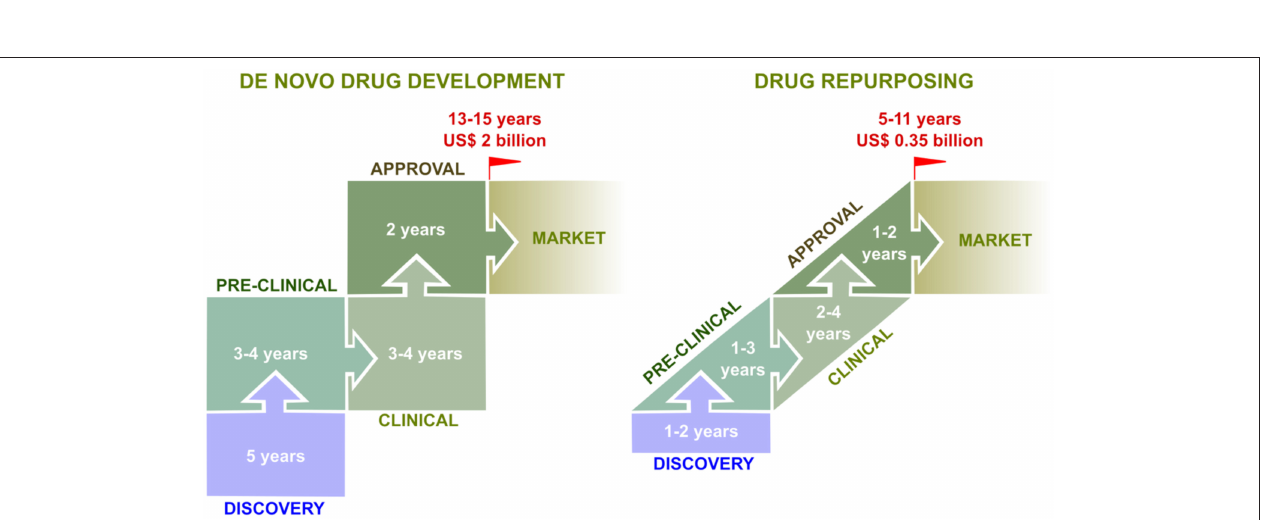
FIGURE 1 | From the bench to the bedside: comparison between de novo drug development and drug repurposing. De novo (classic) drug development constitutes a time-consuming and expensive process. From initial discovery to market, it generally takes 13–15 years and costs up to US$ 2 billion, with a very low success rate (10%). In contrast, drug repurposing approaches offer several advantages. Indeed, the time frame from discovery to market is shorter (5–11 years), less expensive (US$ 350 million), and with a higher success rate (30%), mostly because a large part of preclinical and clinical testings (e.g., safety, formulation, posology) have been already performed for the drug’s initial therapeutic indication (41,